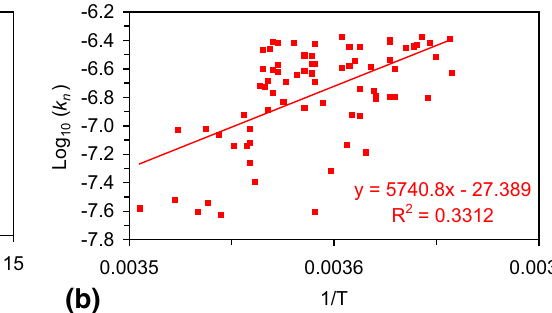
n = 73, k k / P n = w . The saline water was constructed by adding NaCl to natural spring water. The composition of the natural spring water is provided in Antia (2015a,